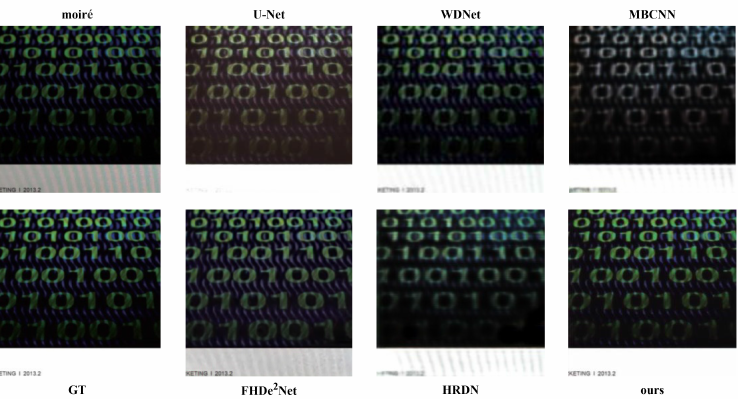
Figure 4. Visual comparisons between our proposed FSD-Net and other